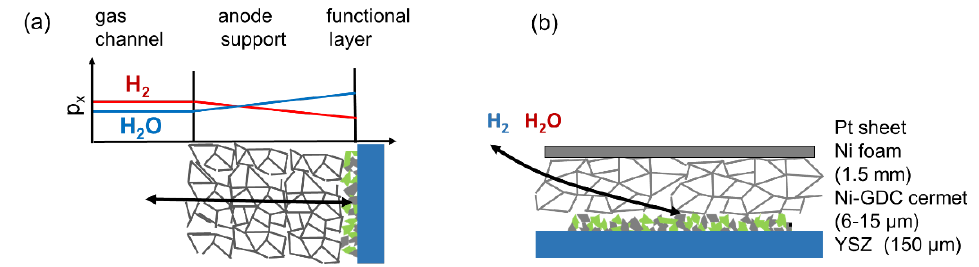
Figure 6. ( a ) Sketch of gas diffusion concentration gradients in a porous electrode support structure, with primary diffusion direction perpendicular to the electrode. ( b ) Gas diffusion in the used symmetrical anode testing setup, with primary diffusion direction in-plane of the electrode.